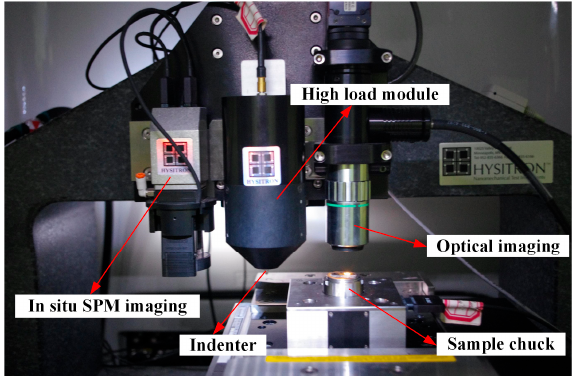
Figure 3. Core components of the TI 950 Triboindenter.